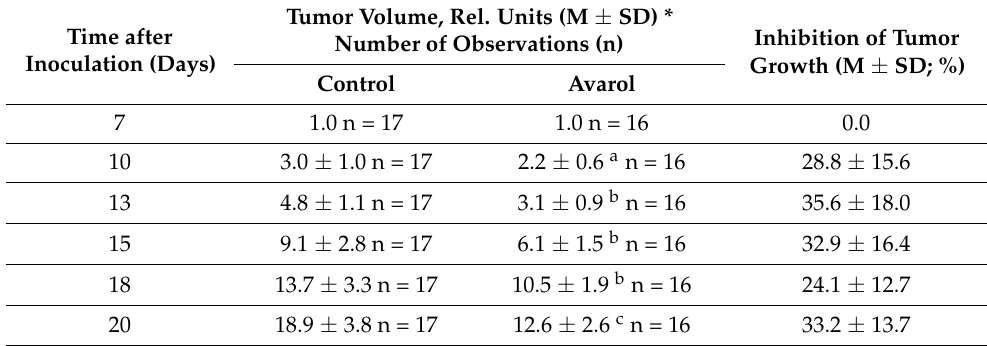
Inhibition of Tu- Growth (M ± SD; %)